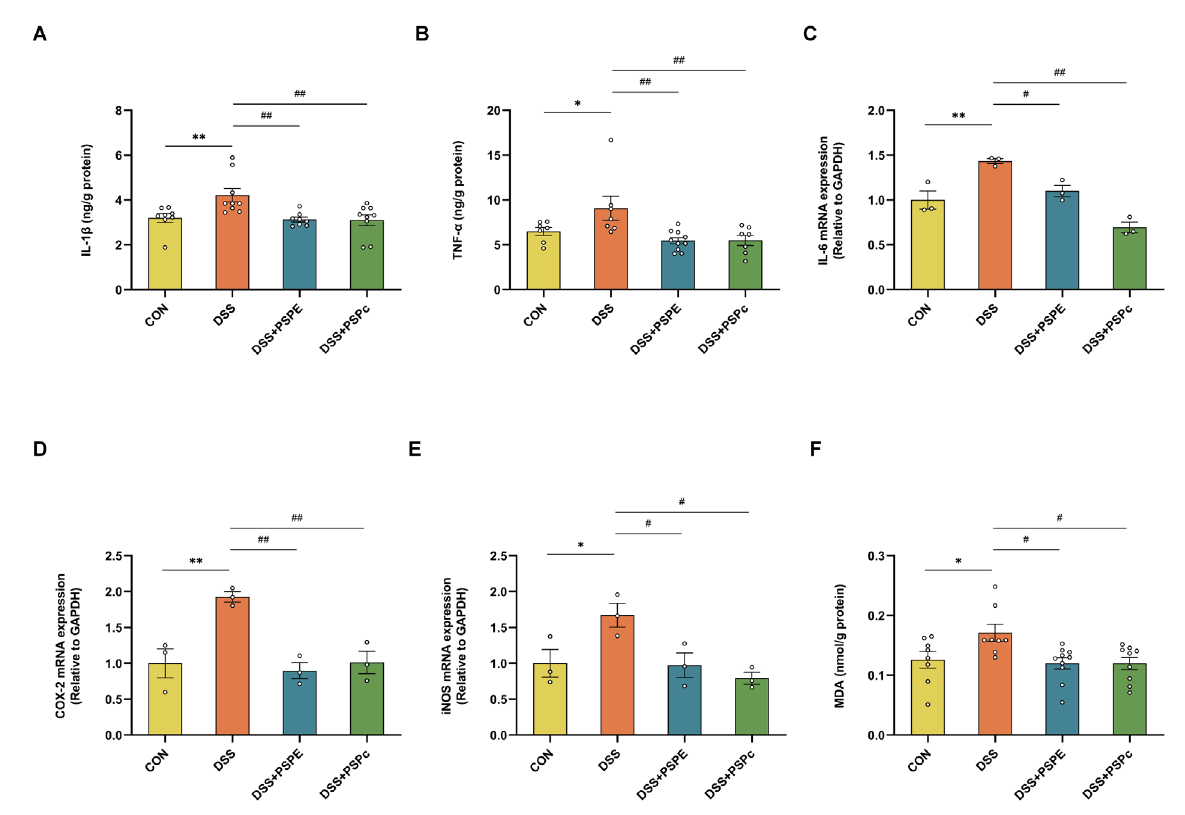
Figure 3. Effect of PSPE and PSPc on the proinflammatory cytokines and mRNA expression in colonic tissue. ( A , B ) Proinflammatory cytokines (IL-1 β and TNF- α ) in colonic tissue. Data were expressed as mean ± SE ( n = 7–10 mice). ( C – E ) qRT-PCR expression (IL-6, COX-2, and iNOS). Data were expressed as mean ± SE ( n = 3 mice). ( F ) MDA in colonic tissue. Data were expressed as mean ± SE ( n = 7–10 mice). * p < 0.05, ** p < 0.01, compared with the Con group, # p < 0.05, ## p < 0.01, compared with the DSS group, ns = not significant.